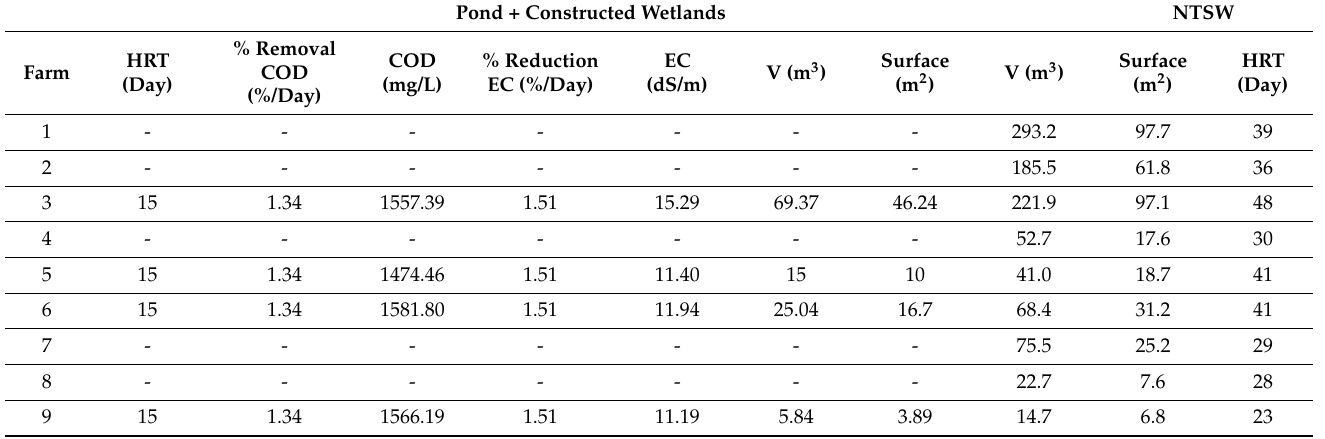
Table 6. Proposed NTSW